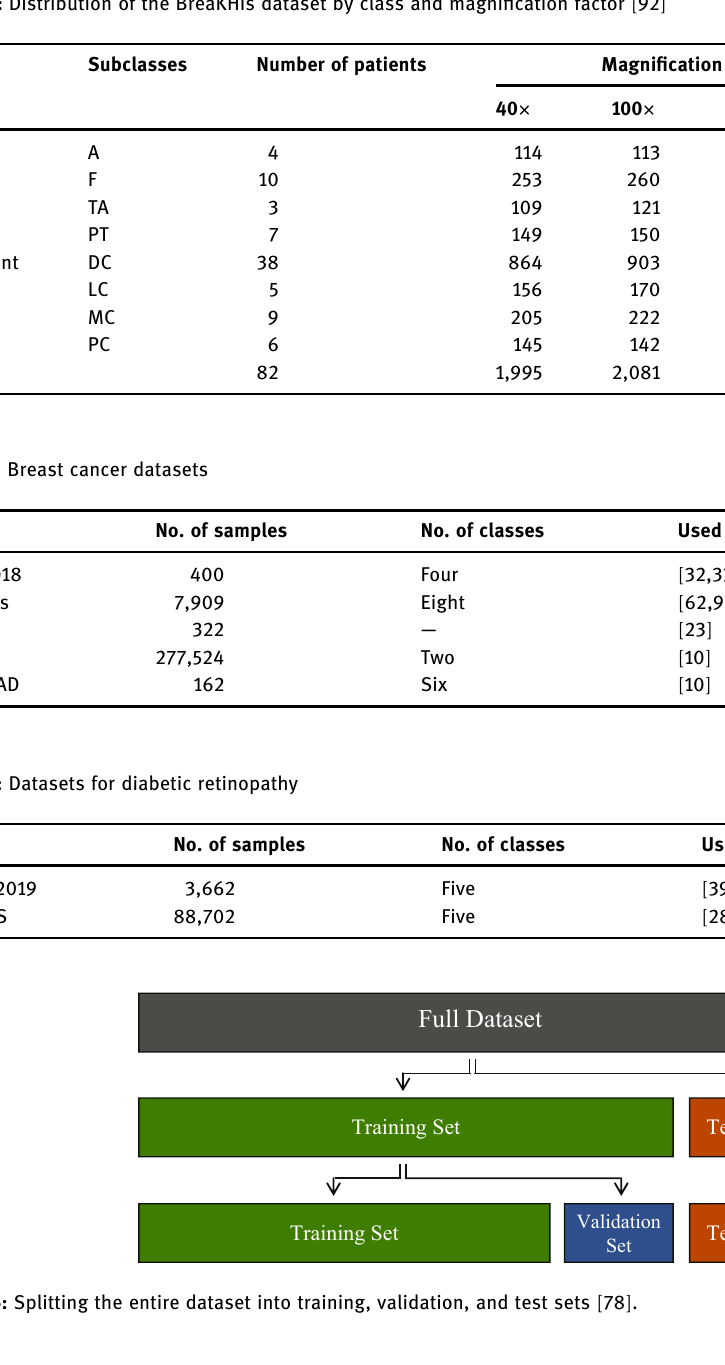
Table 6: Distribution of the BreaKHis dataset by class and magni fi cation factor [ 92 ]